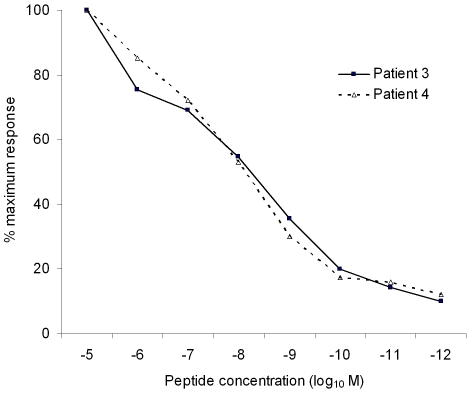
Dose-response titration of the peptide CAPAGFAIL.The responsiveness of T cells from two HIV-infected individuals to 10-fold dilutions of the peptide CAPAGFAIL was assessed by IFN-γ ELISPOT assay. The results shown are the specific response elicited at each peptide concentration, expressed as a percentage of the maximum response (that elicited by 10−5 M peptide) observed in the individual concerned.